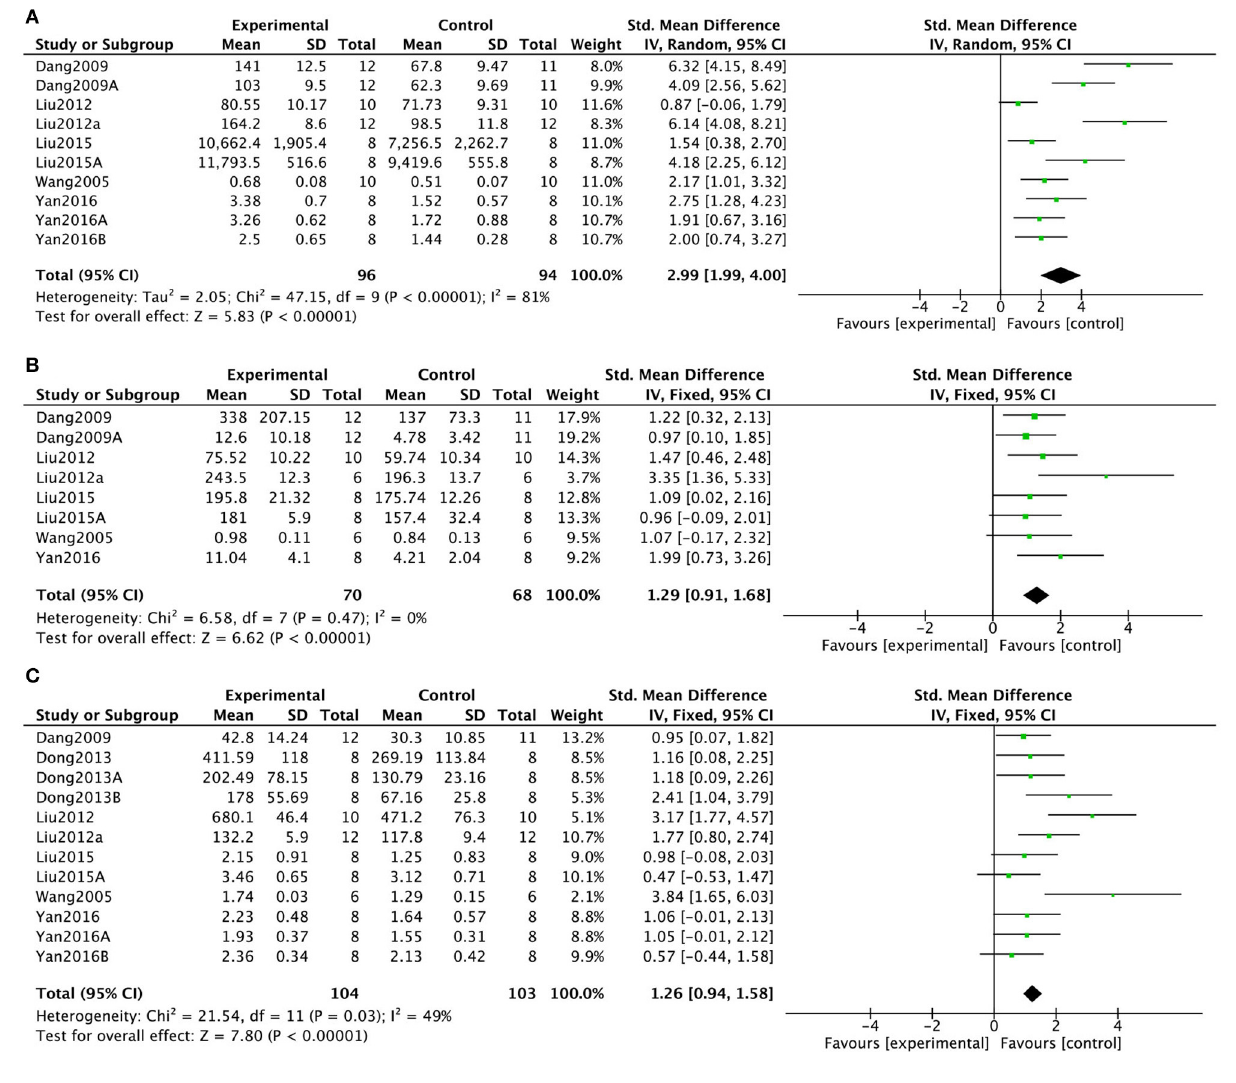
FIGURE 7 | Forest plot showing that KXS NE (A) , DA (B) , and 5-HT (C) levels compared with controls in depression